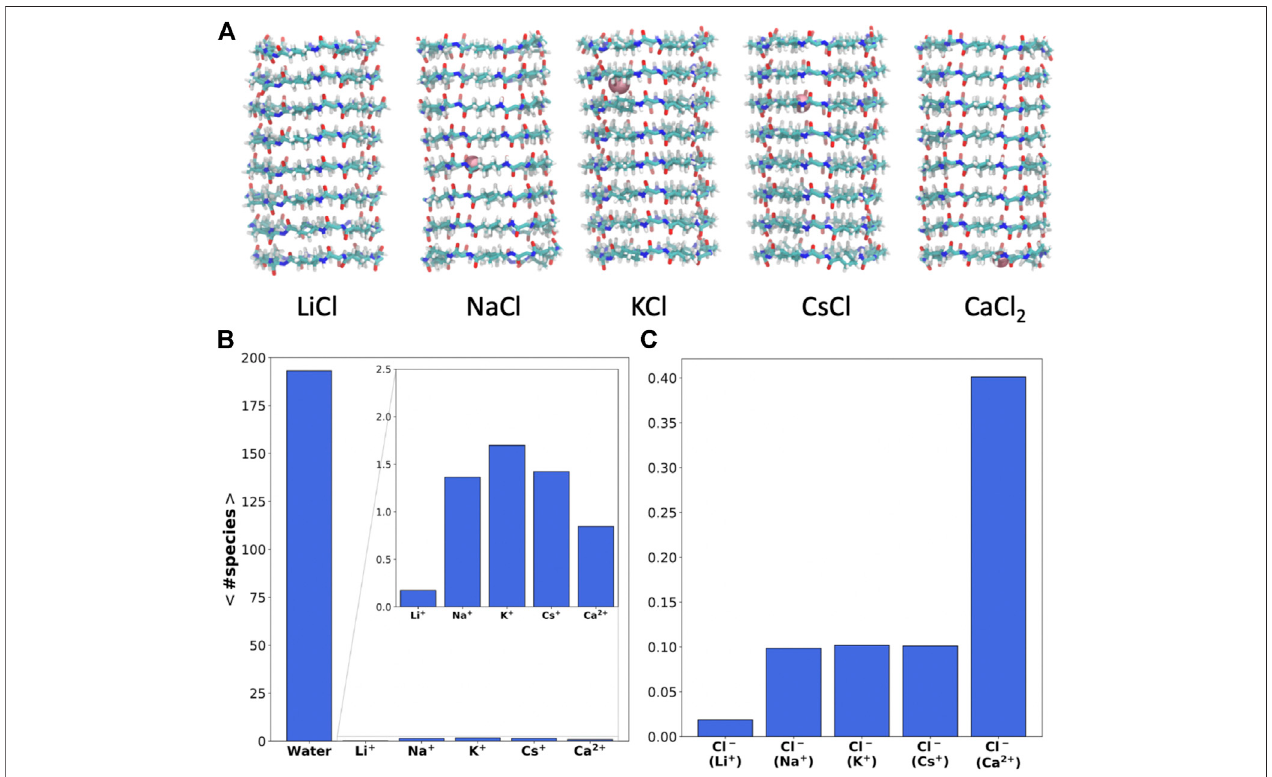
FIGURE 2 | (A) Snapshot of the SCPNs corresponding to the last frame of the MD simulations (t (cid:2) 200 ns), including the ions inside (pink) at that time (the lateral chain is not shown for clarity of the image). (B and C) Average number of cations (B) and anions (C) inside the α , δ -SCPN averaged over the last 180 ns of the MD simulations in LiCl, NaCl, KCl, CsCl, and CaCl 2 0.15 M, respectively. Diving into con fi nement: structure of water and ions inside the α , δ